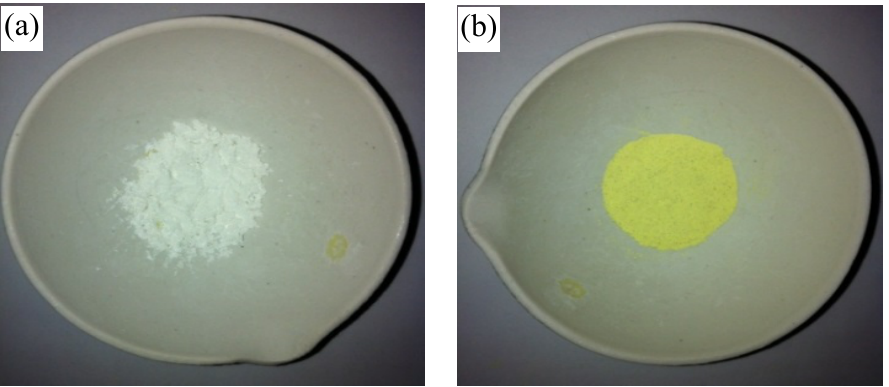
C O as precipitating agent (a) after drying, and (b) after calcination. 2 2 4